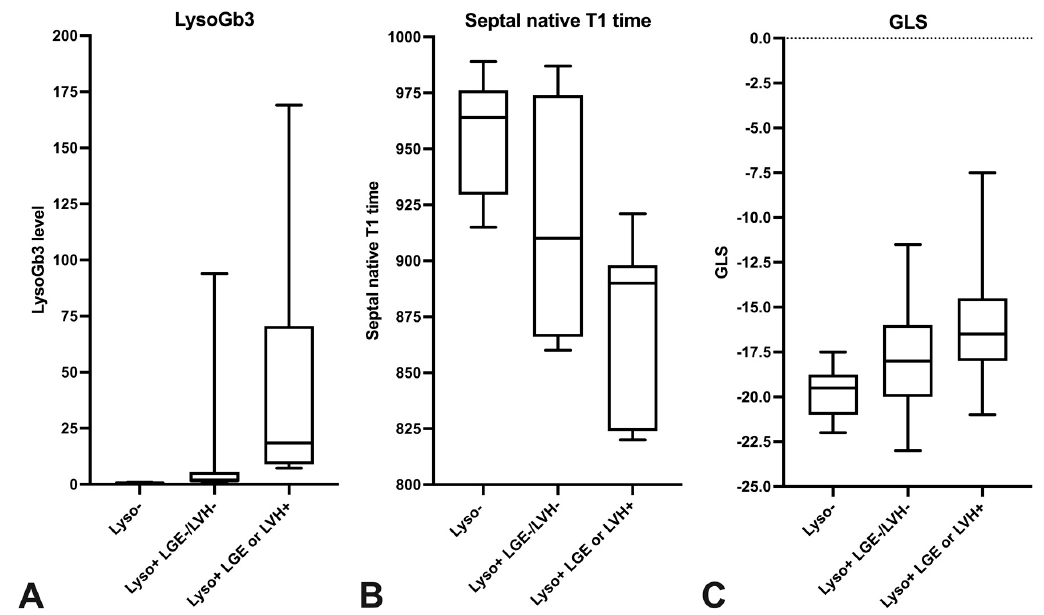
Figure 4. FD patient subgroup analysis. The boxplots present the LysoGb3 level ( A ), the septal native T1 times ( B ) and the global longitudinal strain (GLS) ( C ) of FD patients depending on LysoGb3 positivity and presence of late gadolinium enhancement (LGE) or left ventricular hypertrophy (LVH).